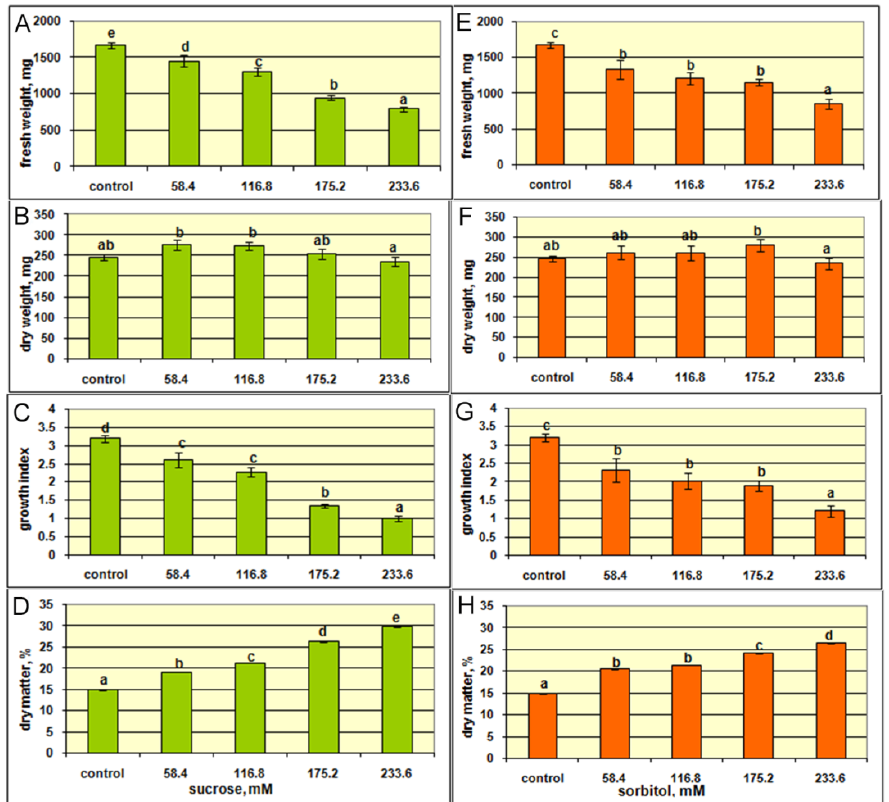
Figure 6. The effect of increasing concentrations (58.4, 161.8, 175.2, and 233.6 mM) of sucrose ( A – D ) and sorbitol ( E – H ) on the growth of shoot cultures of G. lutescens (line 5) after 35 days of culture. The increasing concentrations of sucrose or sorbitol were added into control medium (BM + 0.2 mg L −1 BA containing 58.4 mM sucrose). Values are the means ± SE of eight to ten biological replicates ( n = 8–10). Data were analyzed by one-way ANOVA. Values followed by different letters are significantly different according to Fisher’s LSD test at p ≤ 0.05.